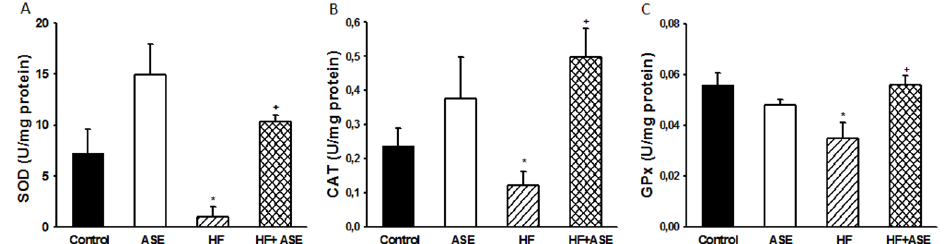
Fig 8. Antioxidant enzyme activities. Effects of ASE on superoxide dismutase (A), catalase (B) and glutathione peroxidase (C) activities in liver from HF fed mice. Values are means ± SEM, n = 8 for all groups. * Significantly different from the control and ASE groups (p (cid:1) .05). + Significantly different from the corresponding HF group (p (cid:1)